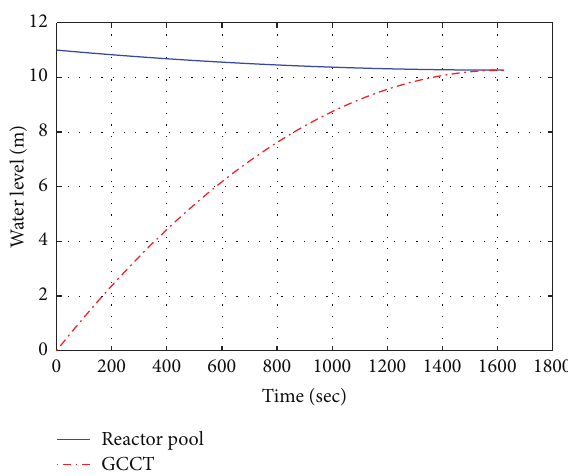
Figure 10: Coastdown of the pump with time (designed). Figure 10. It was sufficient to maintain the downward flow to remove the core decay heat until approximately 130 seconds.